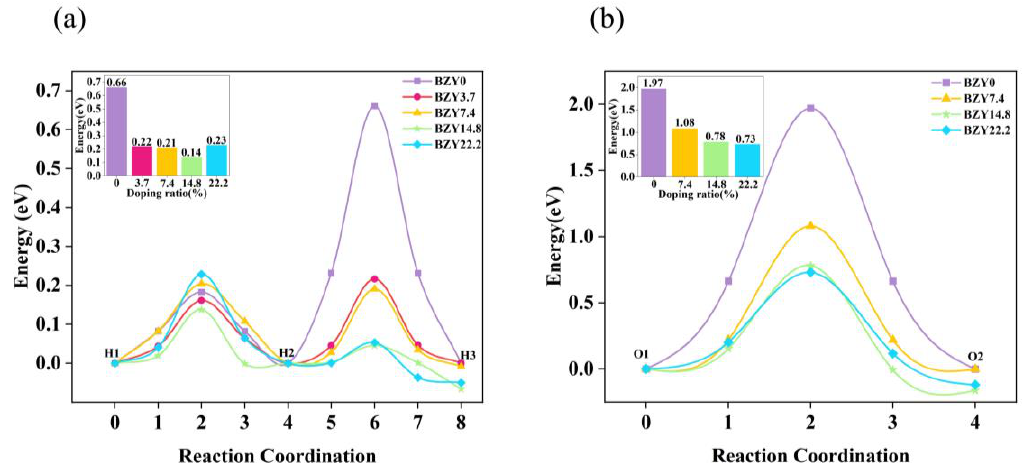
Figure 7. ( a ) Schematic diagram of the oxygen ion migration pathway in BO 6 (B = Zr, Y). Migration